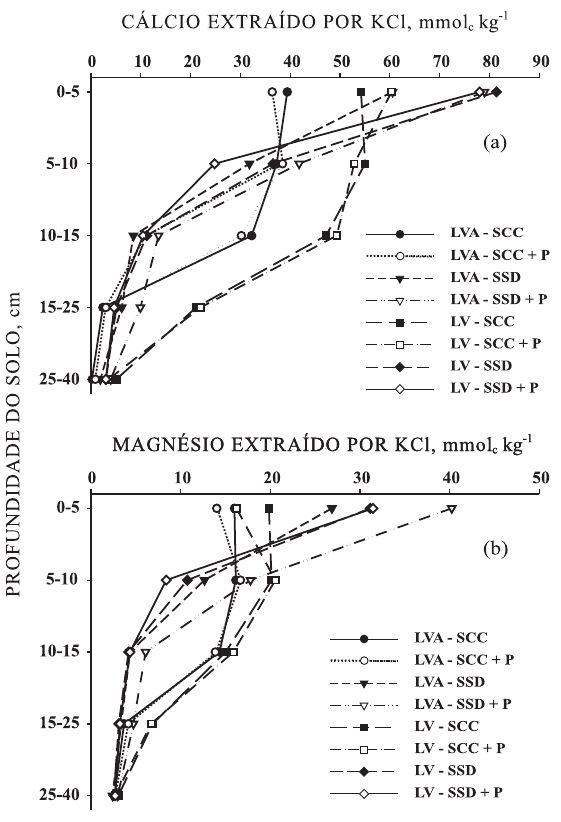
Figura 4. Teores de cálcio (a) e de magnésio trocável (b) nos solos LVA e LV sob dois sistemas de manejo (SCC e SSD), com e sem fertilizante fosfatado